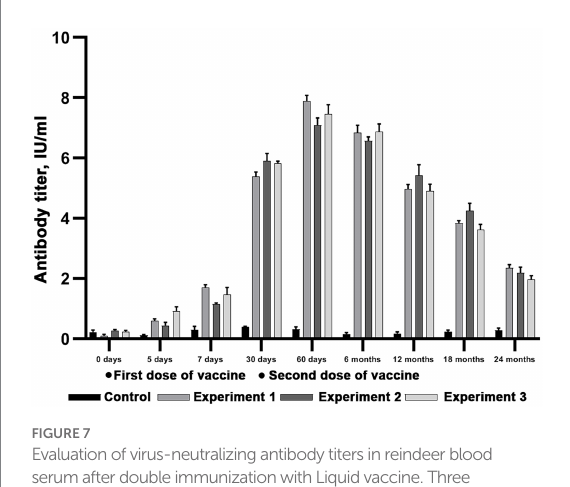
FIGURE 7 Evaluation of virus-neutralizing antibody titers in reindeer blood serum after double immunization with Liquid vaccine. Three independent experiments (Experiment 1, Experiment 2 and Experiment 3). In each experiment, 6 animals were vaccinated in doses equal to 3 ml. Two unvaccinated animals were used as a control group. The standard deviation is illustrated with whisker caps.